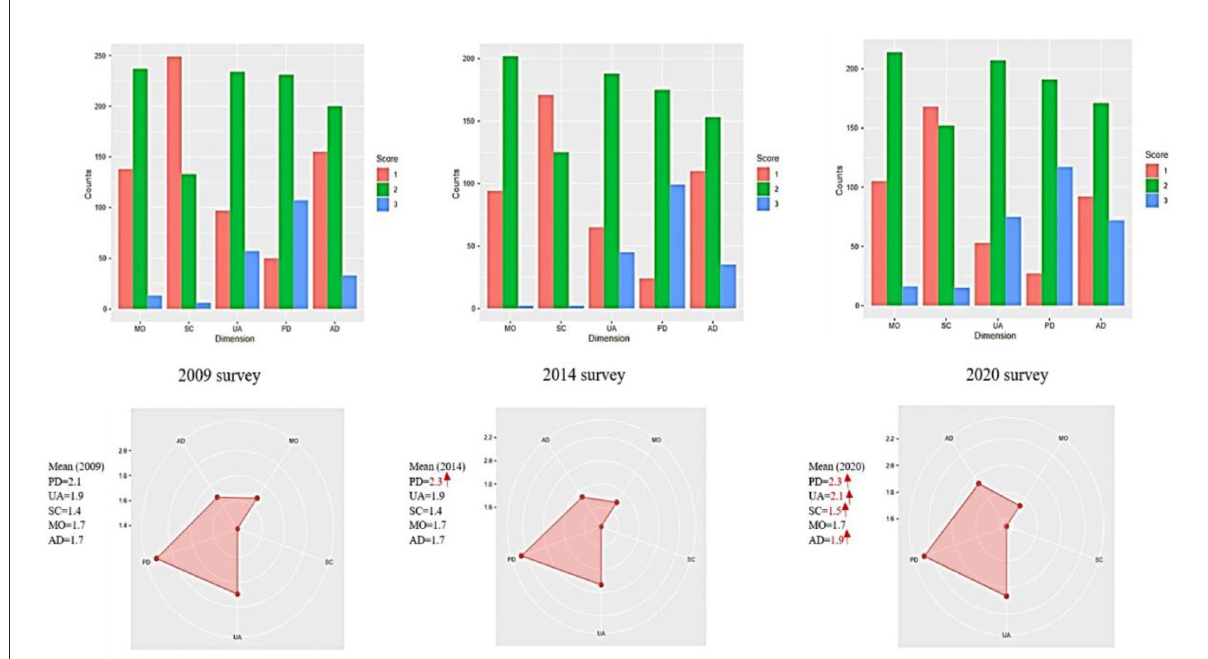
FIGURE2 The mean values of EQ-5D 3L domains: mobility (MO), self-care (SC), usual activity (UA), pain and discomfort (PD), and anxiety/depression (AD), and the number of patients’ responses in 2009, 2014, and 2020 surveys. 3L (three levels); 1 = no problem, 2 = some problems, and 3 = severe problems.